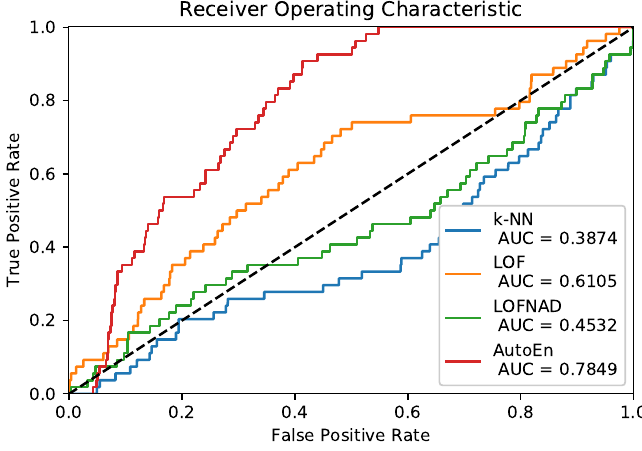
Figure 6. The ROCs and the AUC